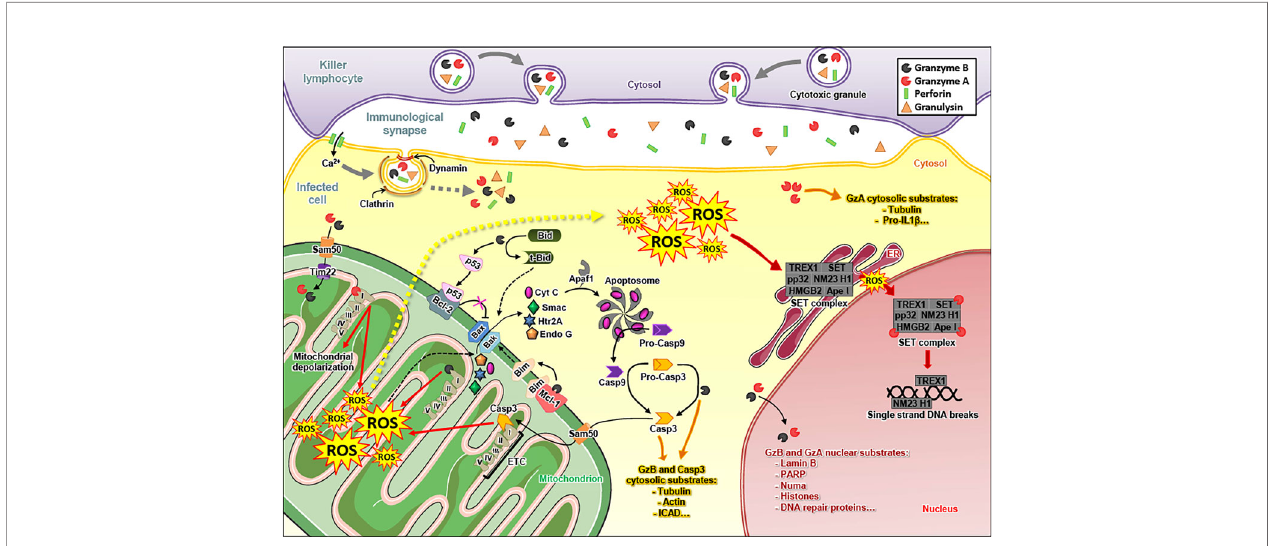
FIGURE 1 | Granzyme A and Granzyme B induce apoptosis of infected cells. The killer lymphocyte releases the content of its granules in the immunological synapse, i.e. the immune effectors granzyme A (GzmA), granzyme B (GzmB), perforin (PFN) and granulysin (GNLY). The endocytosis of GzmA, GzmB, PFN and GNLY in the infected cell is mediated by a PFN-dependent calcium (Ca 2+ ) in fl ux and relies on clathrin and dynamin. Once in the cytosol, GzmA and GzmB cleave various substrates. GzmB triggers the formation of Bax/Bak pores in the outer mitochondrial membrane by cleaving Bid (in truncated-Bid, t-Bid), Mcl-1 (which releases Bim) (12) and p53 (which inhibits Bcl2) (13). GzmB also directly cleaves and matures pro-caspase 3 (Pro-Casp3) into active caspase 3 (Casp3). GzmB and caspase 3 target similar substrates that induce apoptosis of the infected cell. GzmA and GzmB enter the mitochondria – via Sam50 and Tim22 – where they target subunits of the electron transport chain (ETC) complex I, leading to the production of reactive oxygen species (ROS). The ROS favor the release of apoptogenic factors through the Bax/Bak pores, such as cytochrome C (Cyt C), Smac, Htr2A and endonuclease G (Endo G) in the cytosol. Cyt C binds Apaf1 to form the apoptosome, which matures the pro-caspase 9 (pro-Casp9) into active caspase 9 (Casp9). It is noteworthy that caspase 3, either activated by GzmB or caspase 9, also reaches the mitochondria – via Sam50 – where it cleaves a subunit of ETC complex I, leading to the production of ROS. Following these events, ROS concentration increases in the cytosol of the infected cell. The cytosolic ROS are involved in the translocation of the SET complex from the endoplasmic reticulum (ER) to the nucleus, where it is cleaved by GzmA and turns into a DNA degrading complex. GzmA and GzmB also reach the nucleus where they cleave nuclear substrates, such as lamin B, histones and